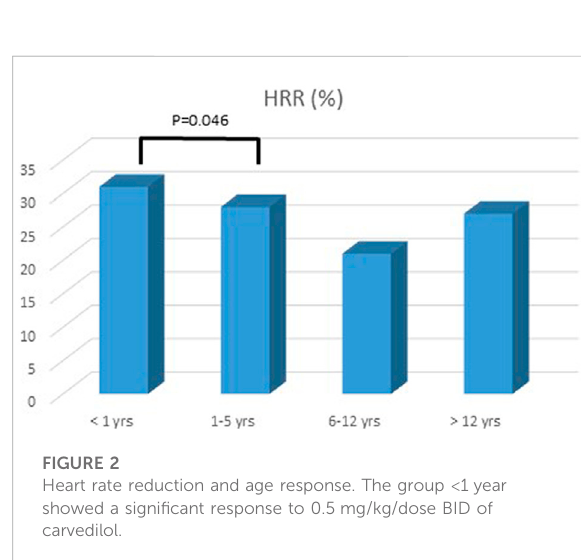
FIGURE 2 Heart rate reduction and age response. The group < 1 year showed a signi fi cant response to 0.5 mg/kg/dose BID of carvedilol.